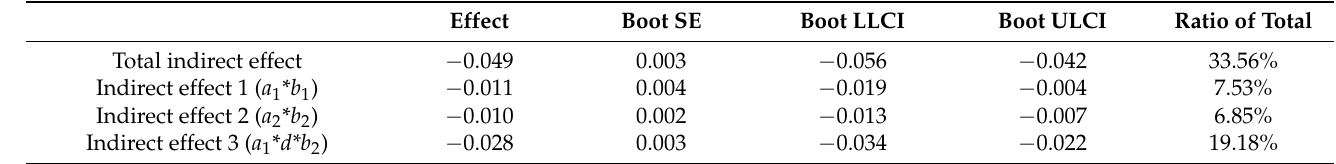
Table 4. Indirect effects of marital satisfaction and coparenting.